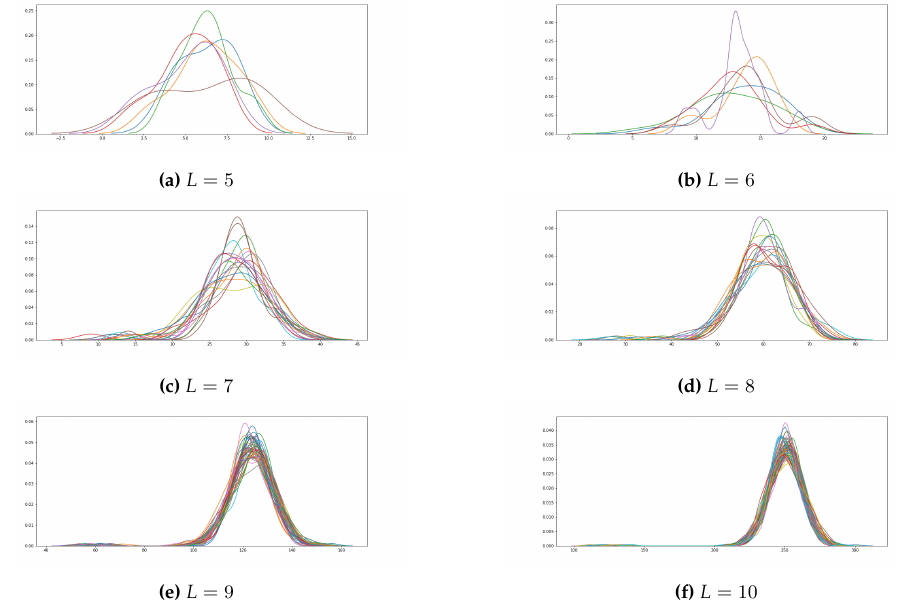
Figure 2. Density of binomial sequences in the GSS-sequence